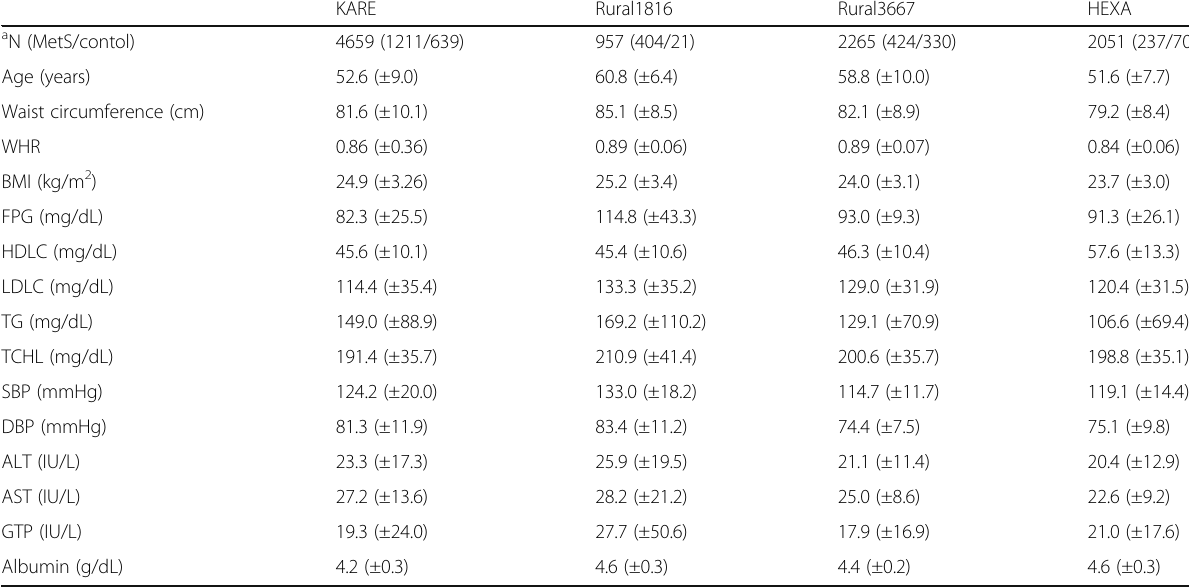
Table 1 Clinical characteristics female subjects in study cohorts. Numbers indicate average and standard deviation for each